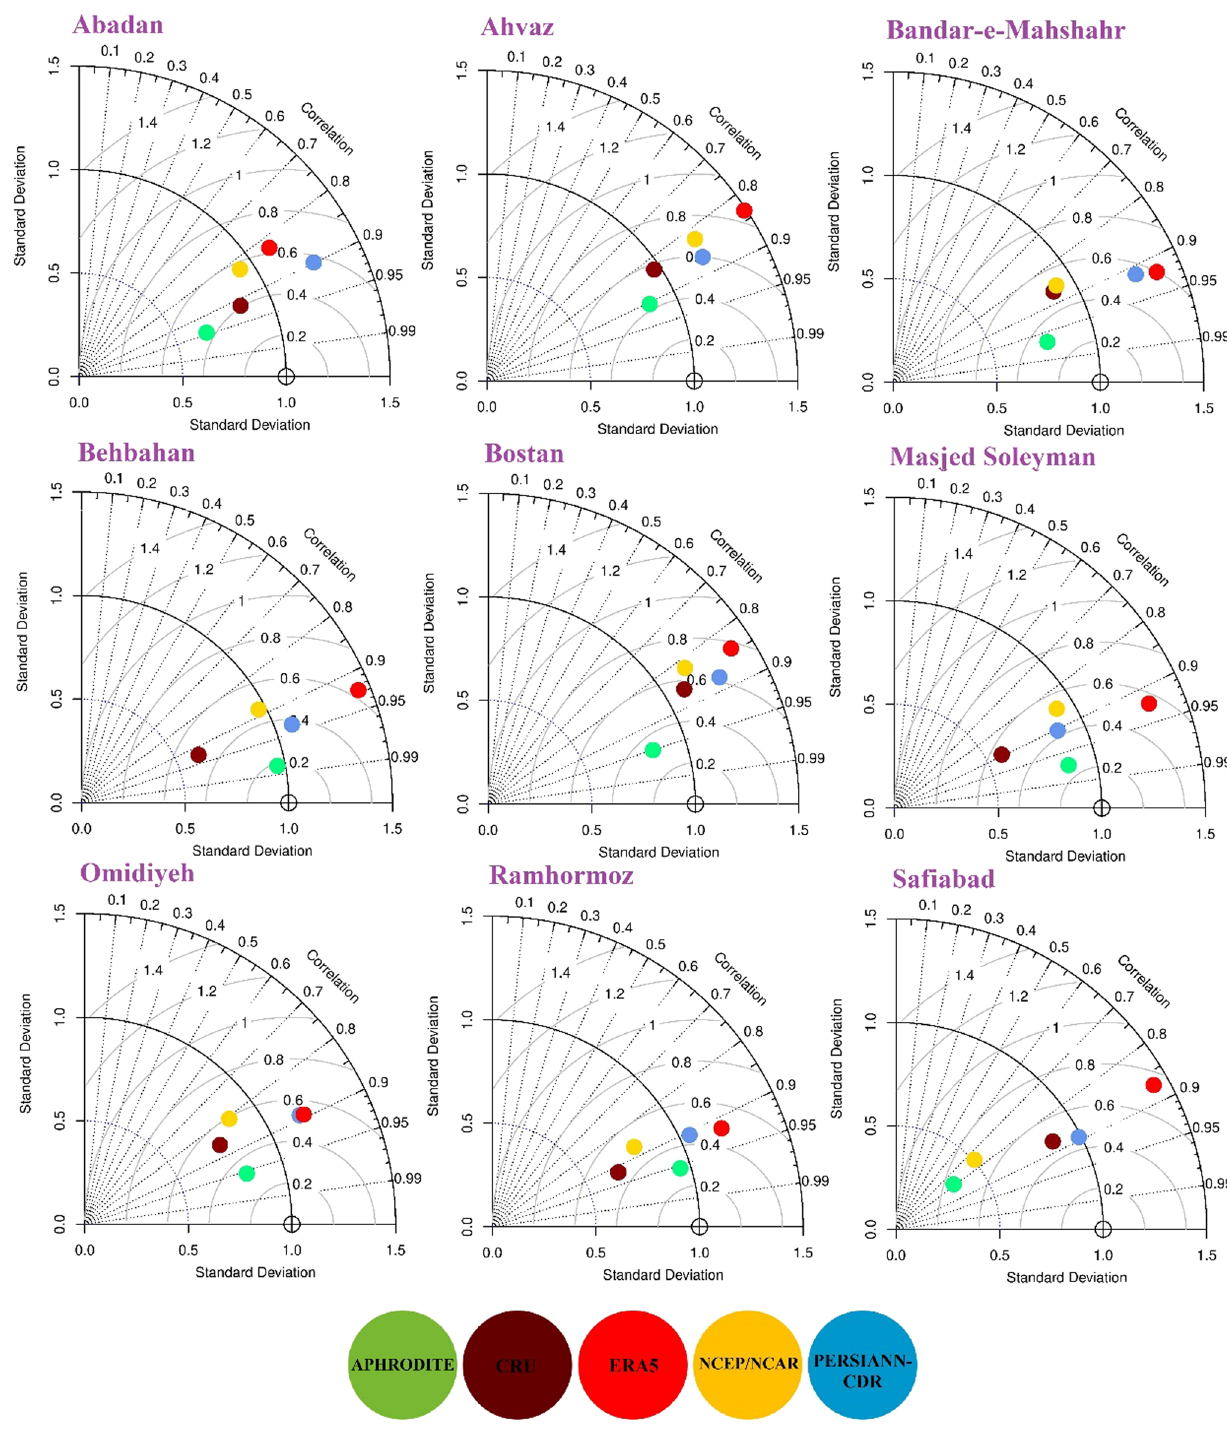
Fig. 3 The Taylor diagrams of five datasets in nine synoptic